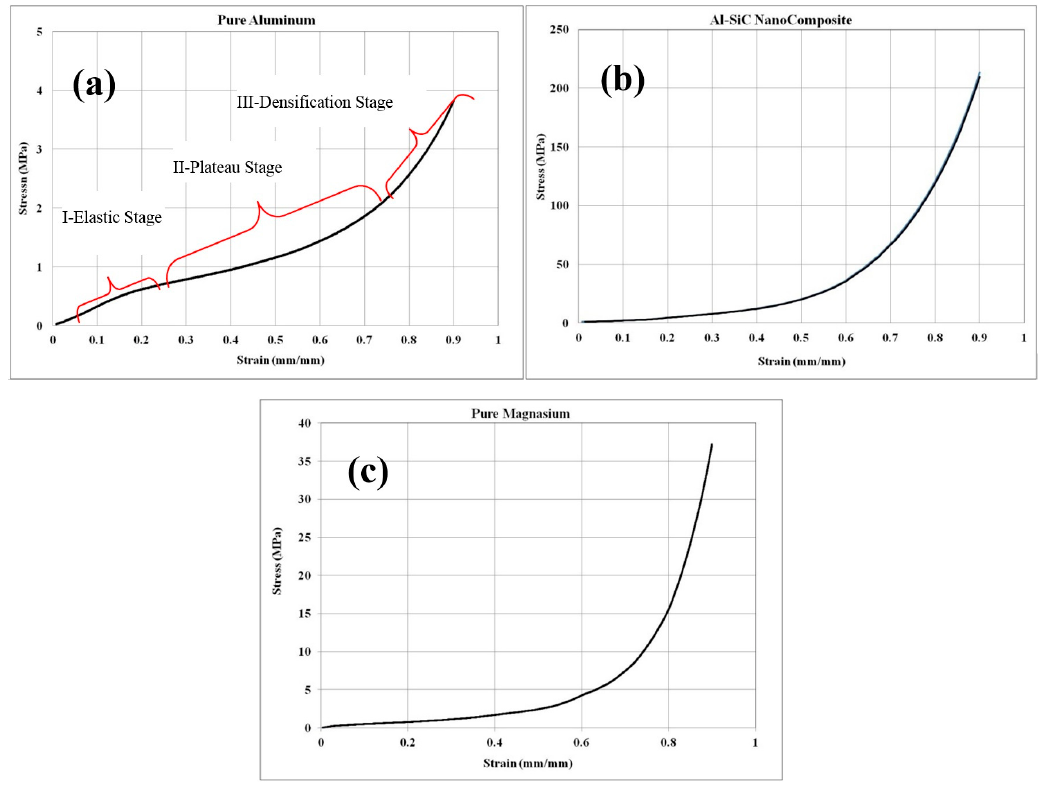
Figure 5. Compressive stress-strain curves of ( a ) pure aluminum foam; ( b ) Al-10% SiC foam ( c ) pure magnesium foam.